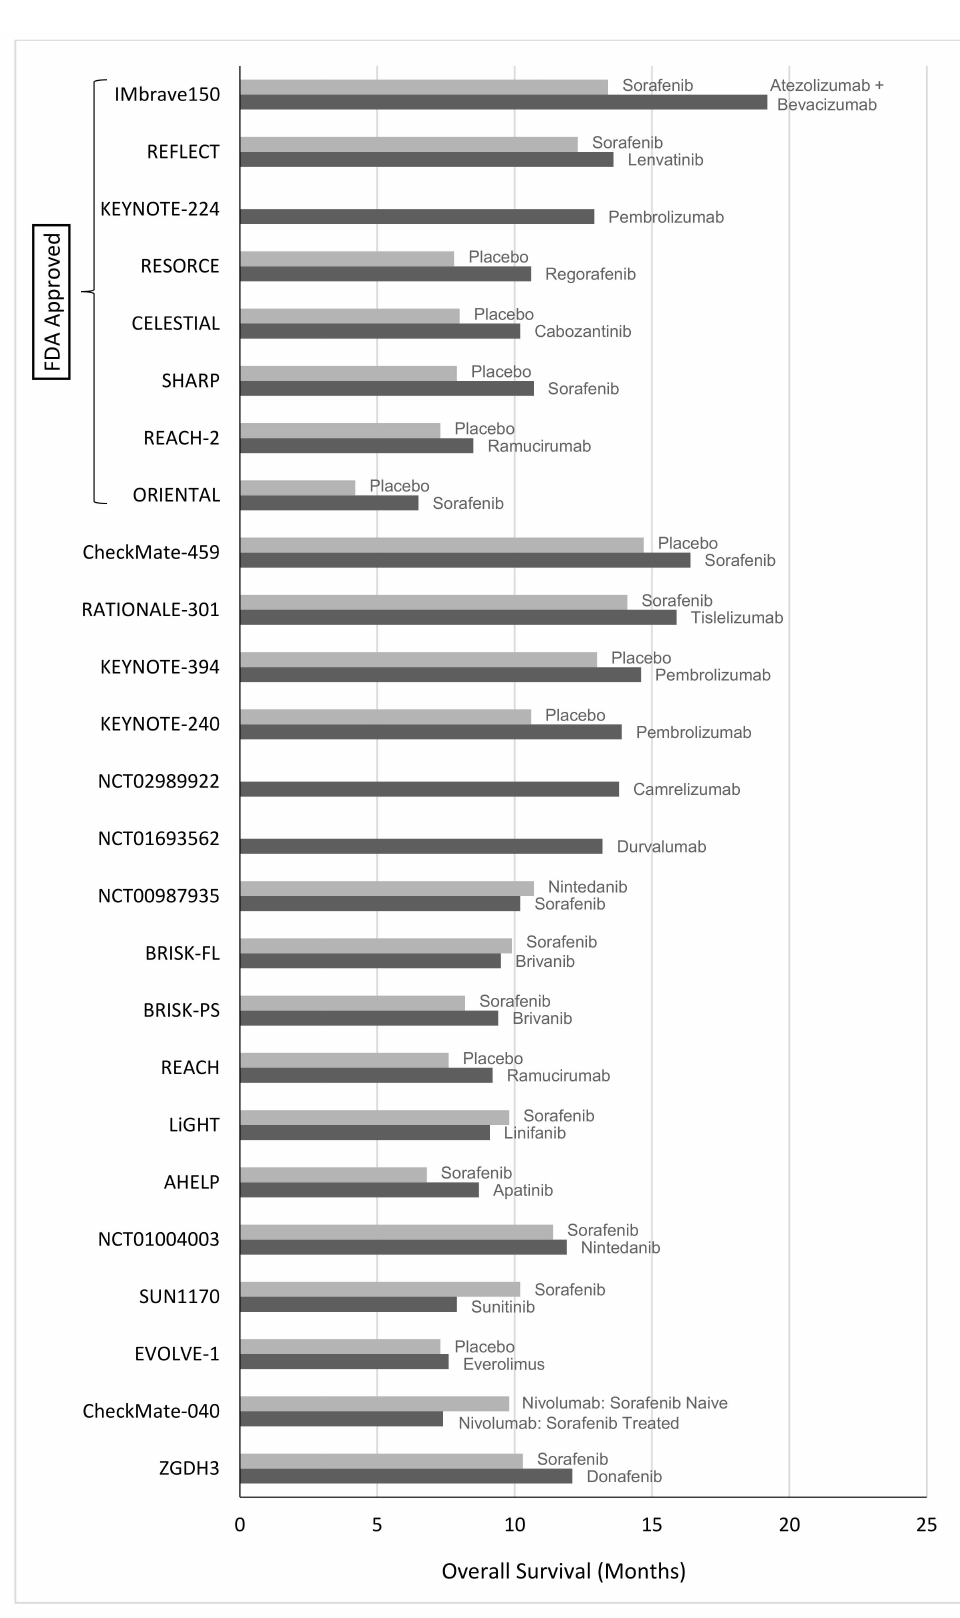
Figure 5. Efficacy of agents used in HCC targeted therapy and immunotherapy based on survival